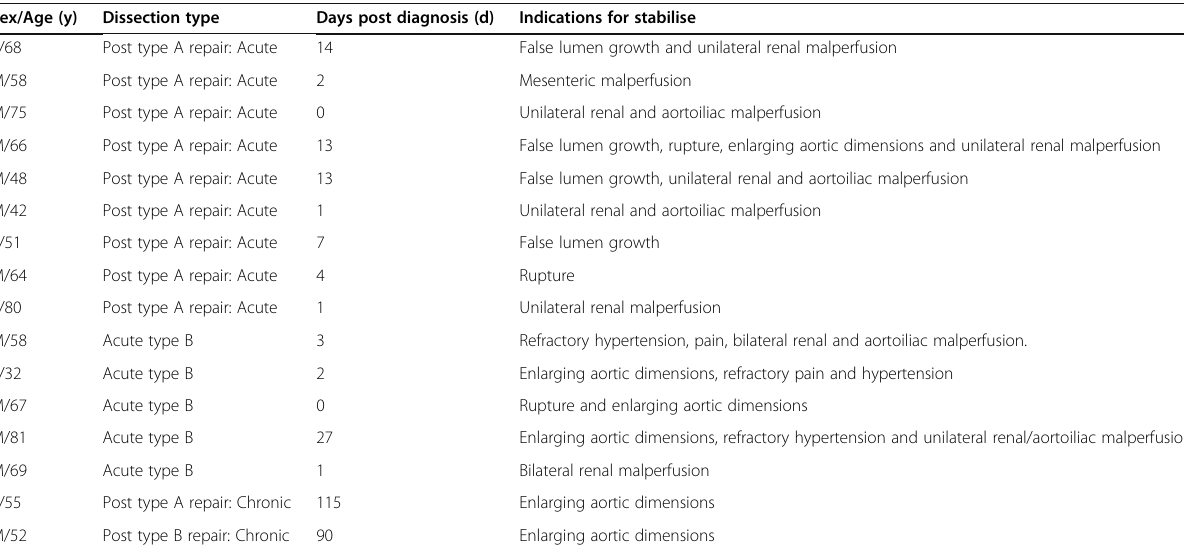
Table 1 Dissection characteristic of patients who underwent STABILISE